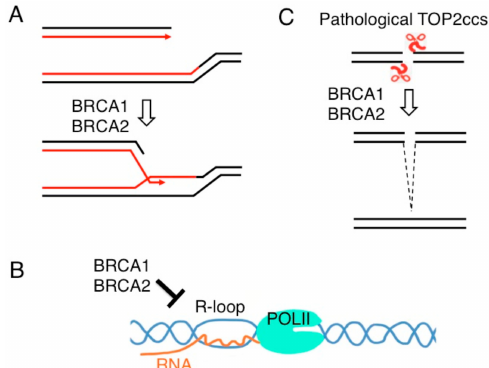
Figure 5. The roles of BRCA1 and BRCA2 in genome maintenance. ( A ) They play a critical role in the repair of DSBs formed during DNA replication by promoting strand exchange between two sister chromatids as shown in Figure 1. ( B ) BRCA1 and BRCA2 reduce the accumulation of transcription-associated R loop. ( C ) BRCA1 and BRCA2 promote the repair of stalled TOP2ccs as shown in Figure